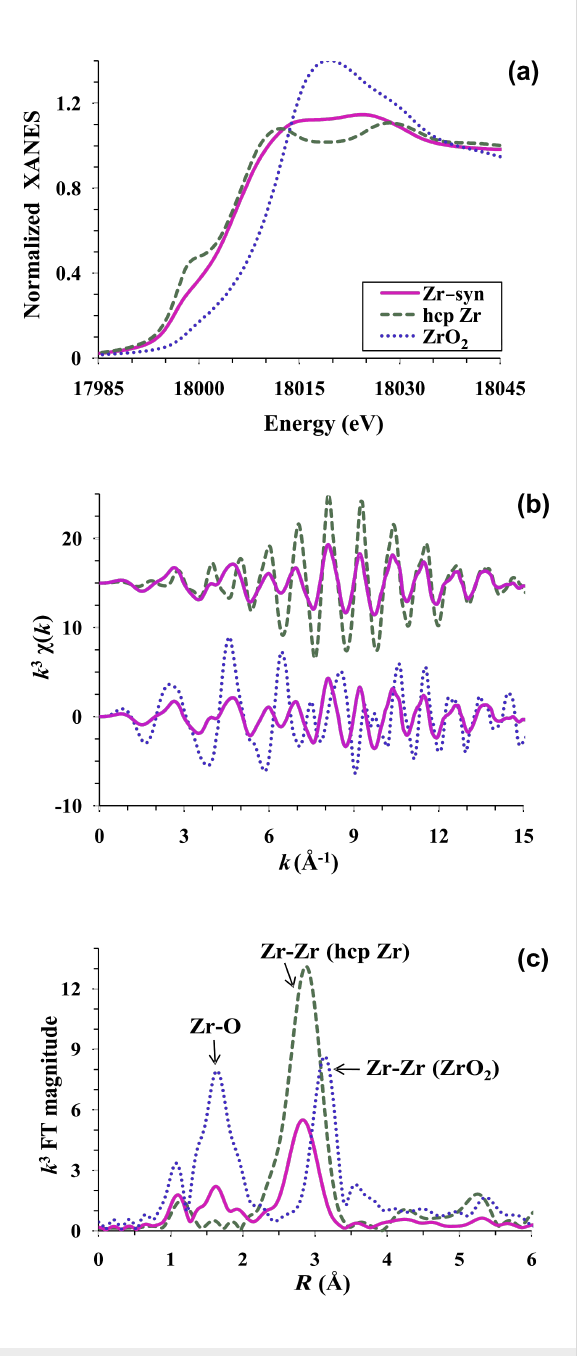
Figure 2: Zr K-edge (a) normalized XANES, (b) k 3 -weighted EXAFS and (c) corresponding Fourier Transform of Zr-syn sample (solid line), standard ZrO 2 (dotted line) and metallic hcp Zr (dashed